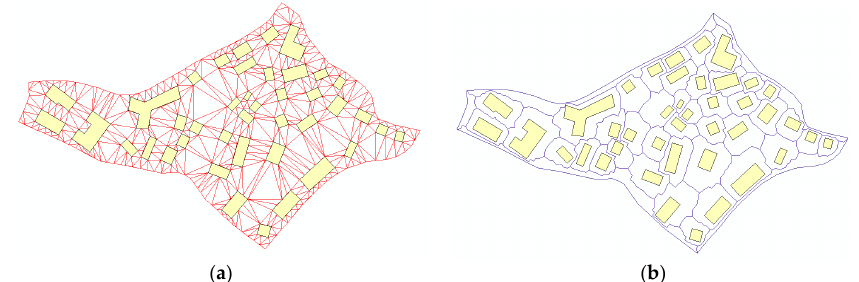
Figure 3. ( a ) The constrained Delaunay triangulation (CDT); ( b ) The skeleton partition network for conflict detection.